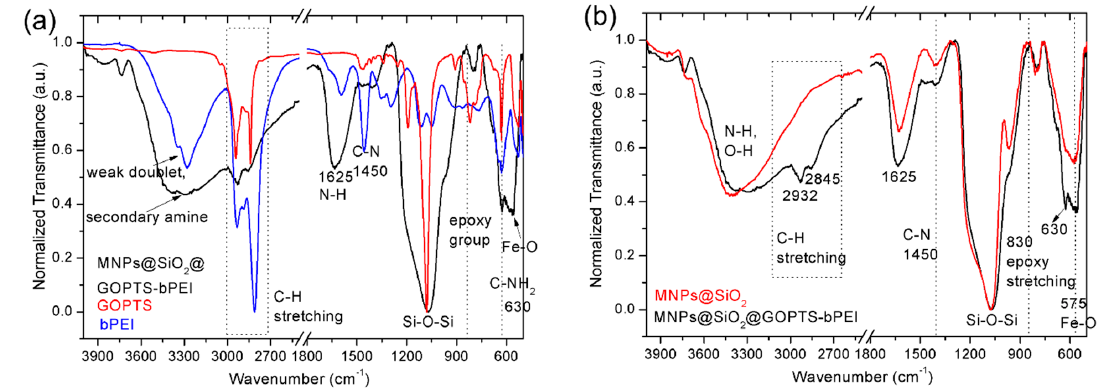
Figure 3. FTIR spectra of MNPs@SiO 2 @GOPTS-bPEI with respect to pure bPEI and GOPTS ( a ). FTIR spectra of MNPs@SiO 2 and MNPs@SiO 2 @GOPTS-bPEI ( b ).